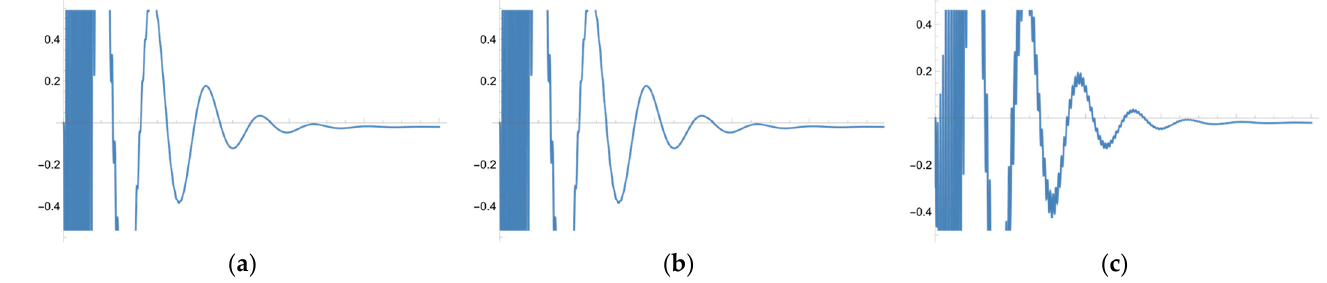
Figure 9. No. 15 state variable I 1 oq ( t ) solved from the 3 models. ( a ) Result from the proposed method,